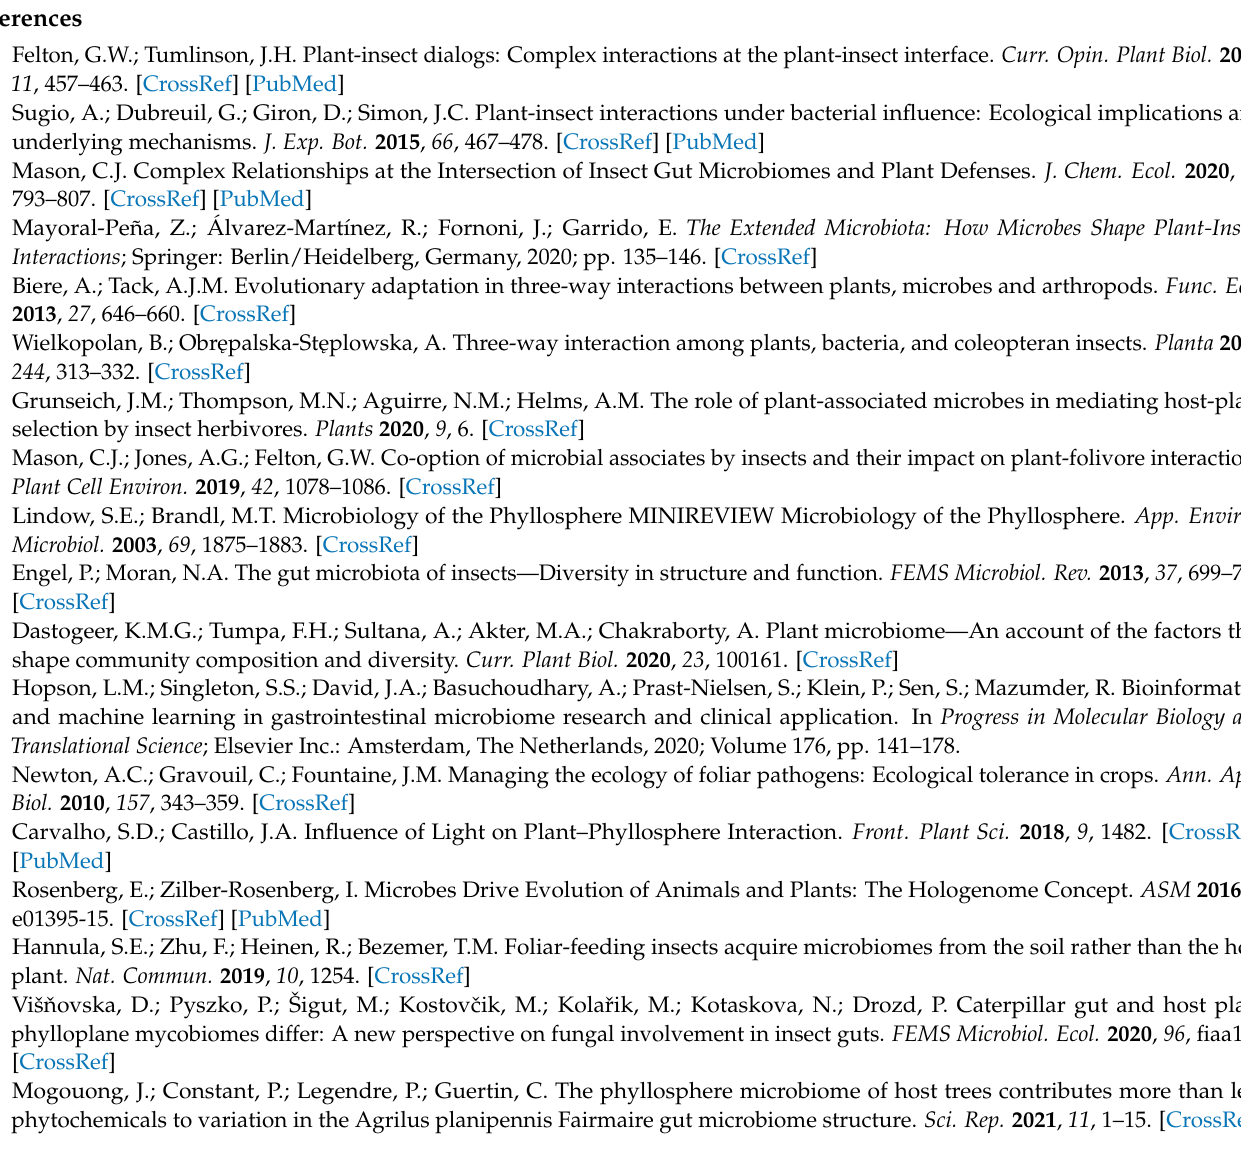
Figure S2: Relative abundance; Figure S3: Shared ASVs; Figure S4: Significant abundances of genera; Table S1: Sequences and ASVs; Table S2: Shared